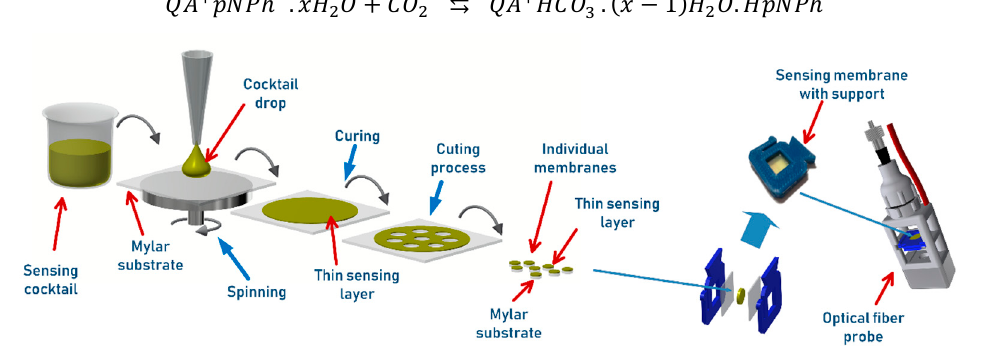
Figure 1. Preparation scheme of the sensing membrane and the optical fiber probe